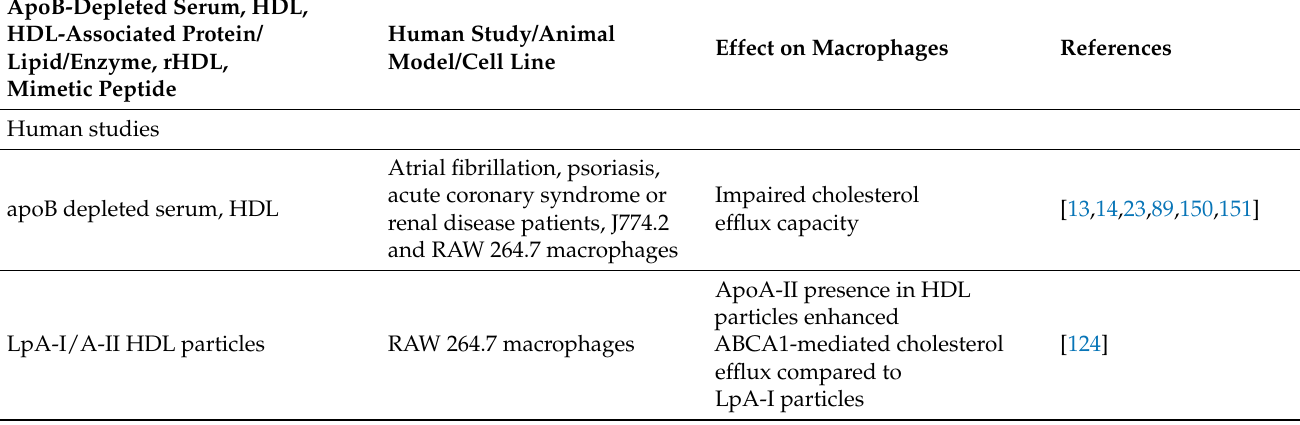
Table 2. Effects of apoB-depleted serum, HDL, reconstituted HDL, HDL-associated apolipoproteins, lipids and enzymes or mimetic peptides on macrophage function in human studies utilizing monocyte-derived macrophages or cell lines and in studies utilizing animal